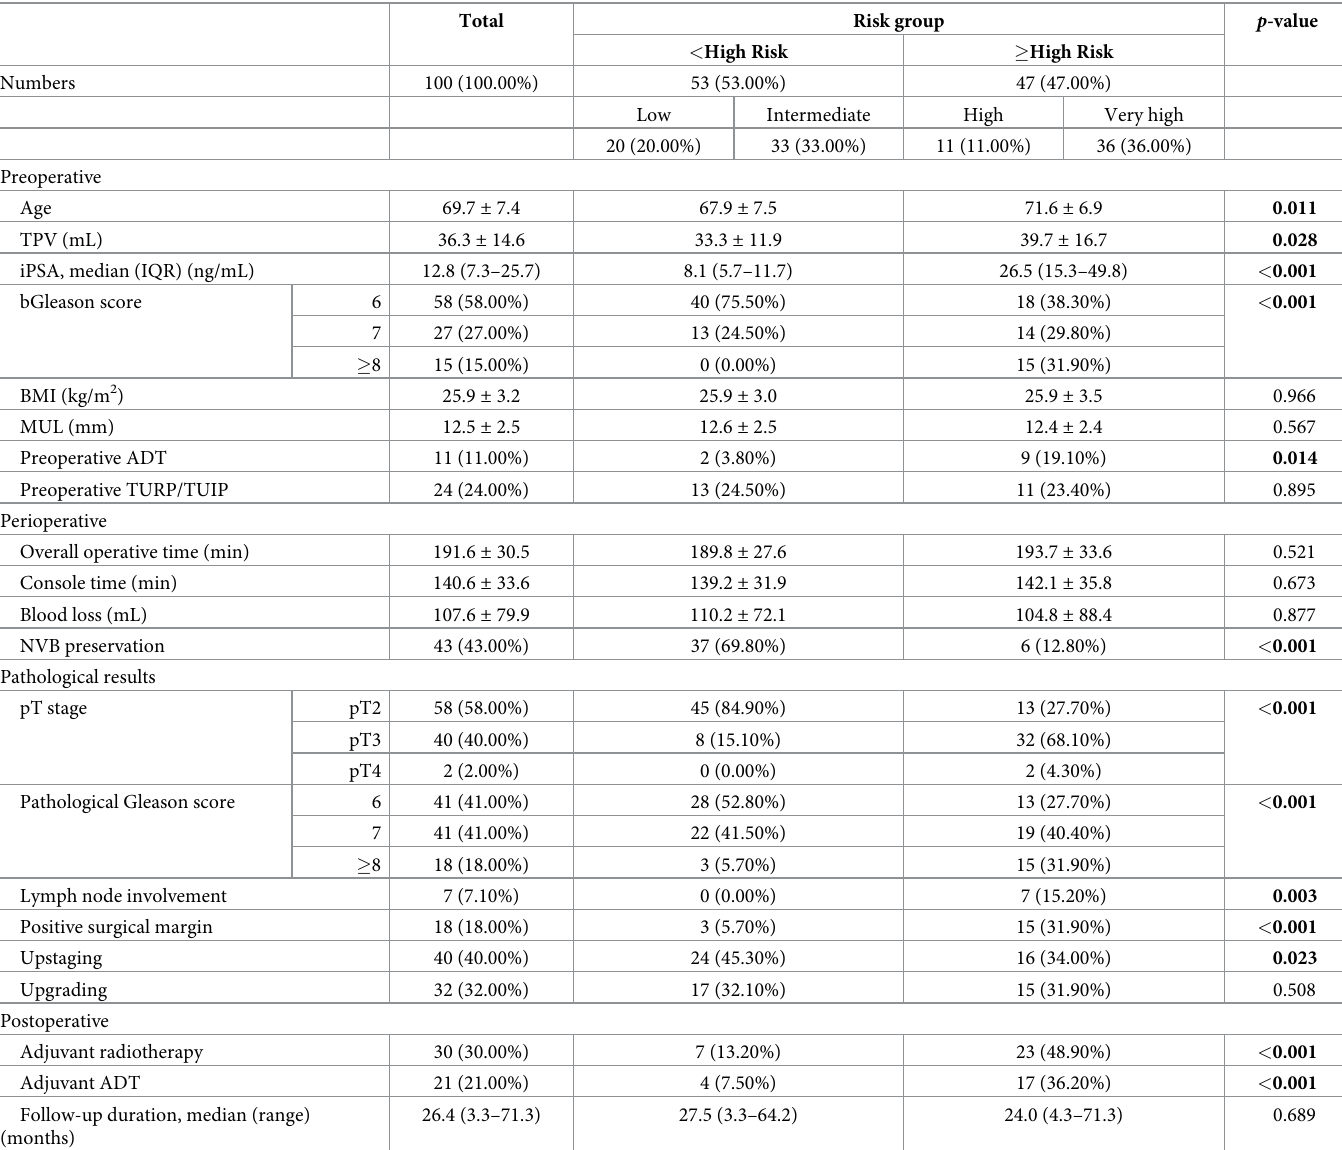
Table 1. Preoperative, perioperative, pathological, and postoperative characteristics of prostate cancer patients (the entire study cohort, n =